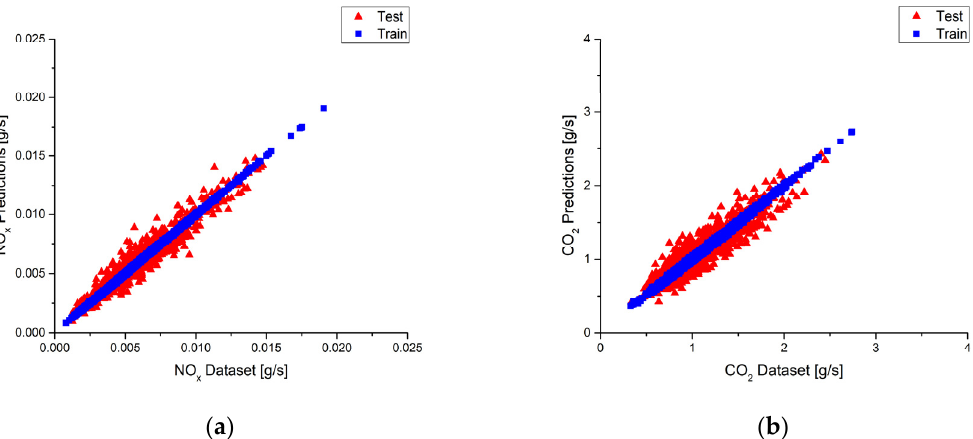
Figure 22. ( a ) Deviations between the predictions and the measurements plot of using the top 4 features NO x model in